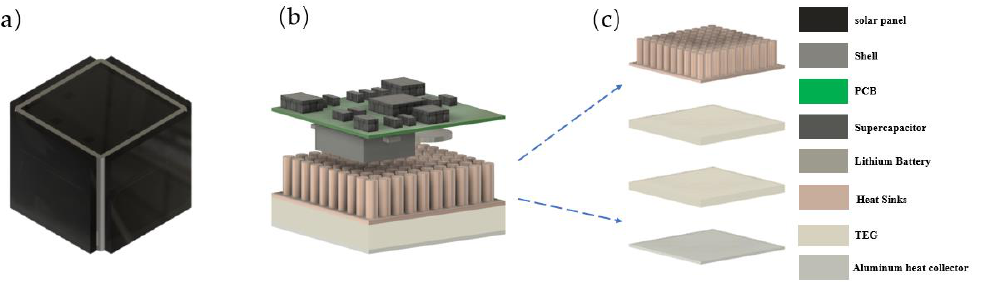
Figure 7. ( a ) 3D model of the self-powered sensor node; ( b ) system internal components; ( c ) the TEG